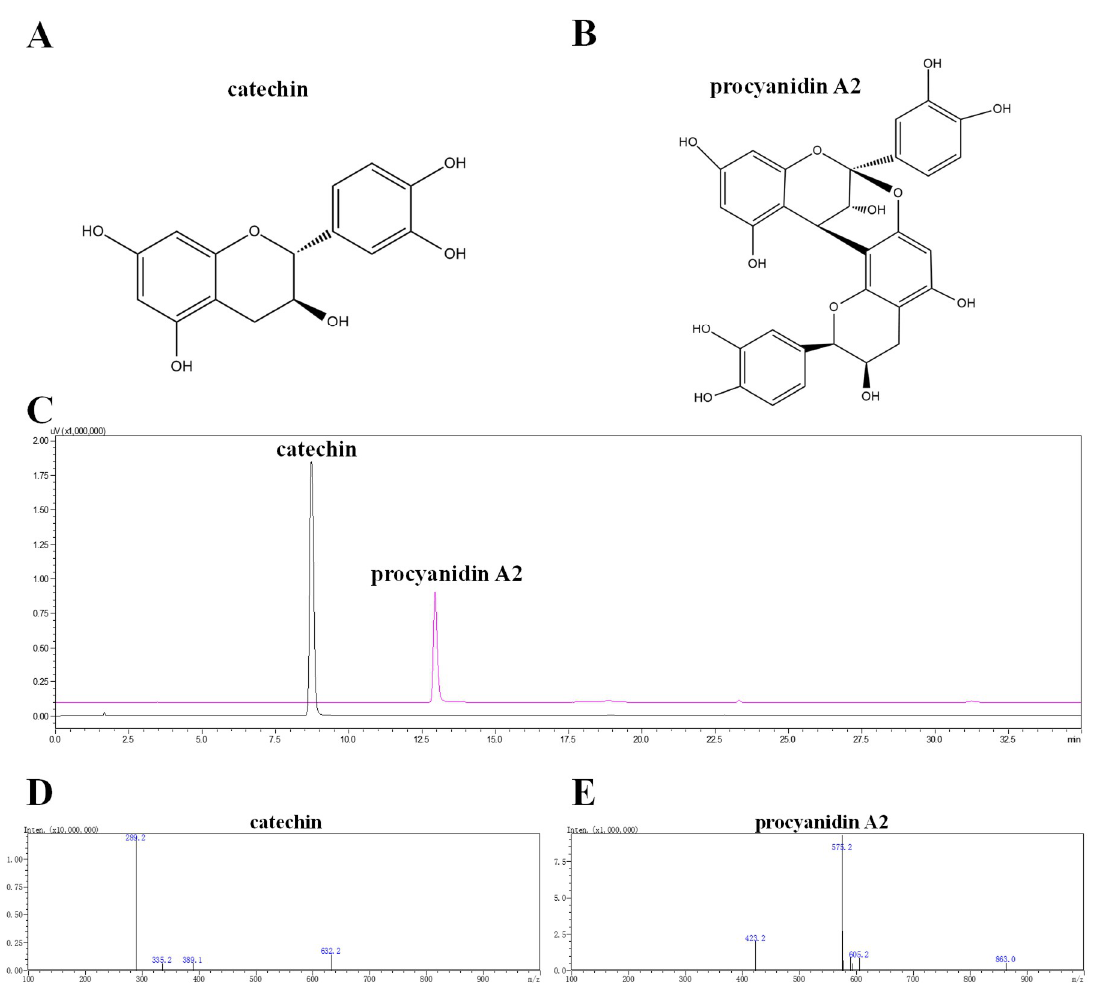
Figure 1. UHPLC-DAD-ESI-MS/MS chromatograms of catechin and procyanidin A2. The structures of ( A ) catechin and ( B ) procyanidin A2. ( C ) DAD chromatograms of catechin and procyanidin A2 recorded at 280 nm, MS spectrum of ( D ) catechin and ( E ) procyanidin A2 in negative mode.